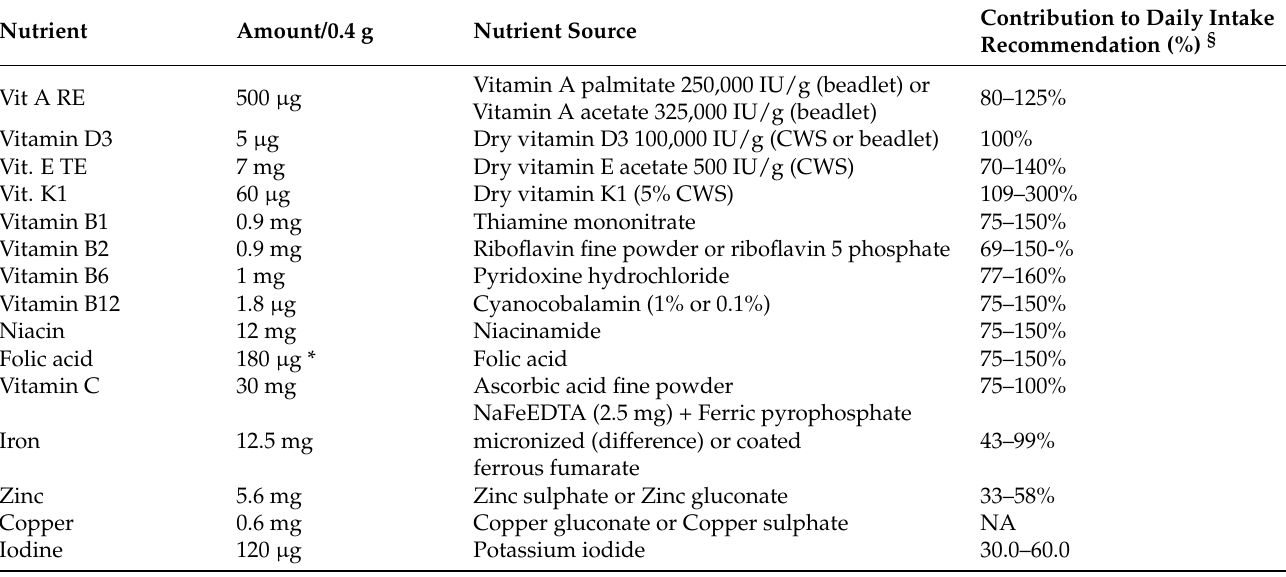
Table 2. Composition of the Micronutrient Powder